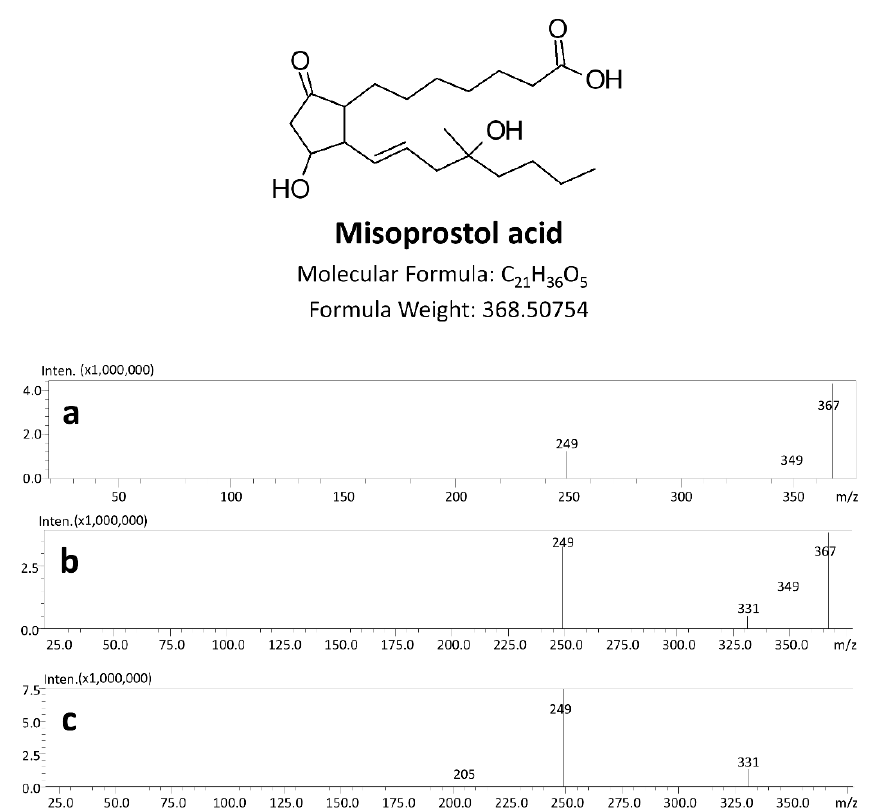
Figure 2. Product ion scan spectra of misoprostol acid at different collision energies: ( a ) 5 V; ( b ) 10 V and ( c ) 20 V.